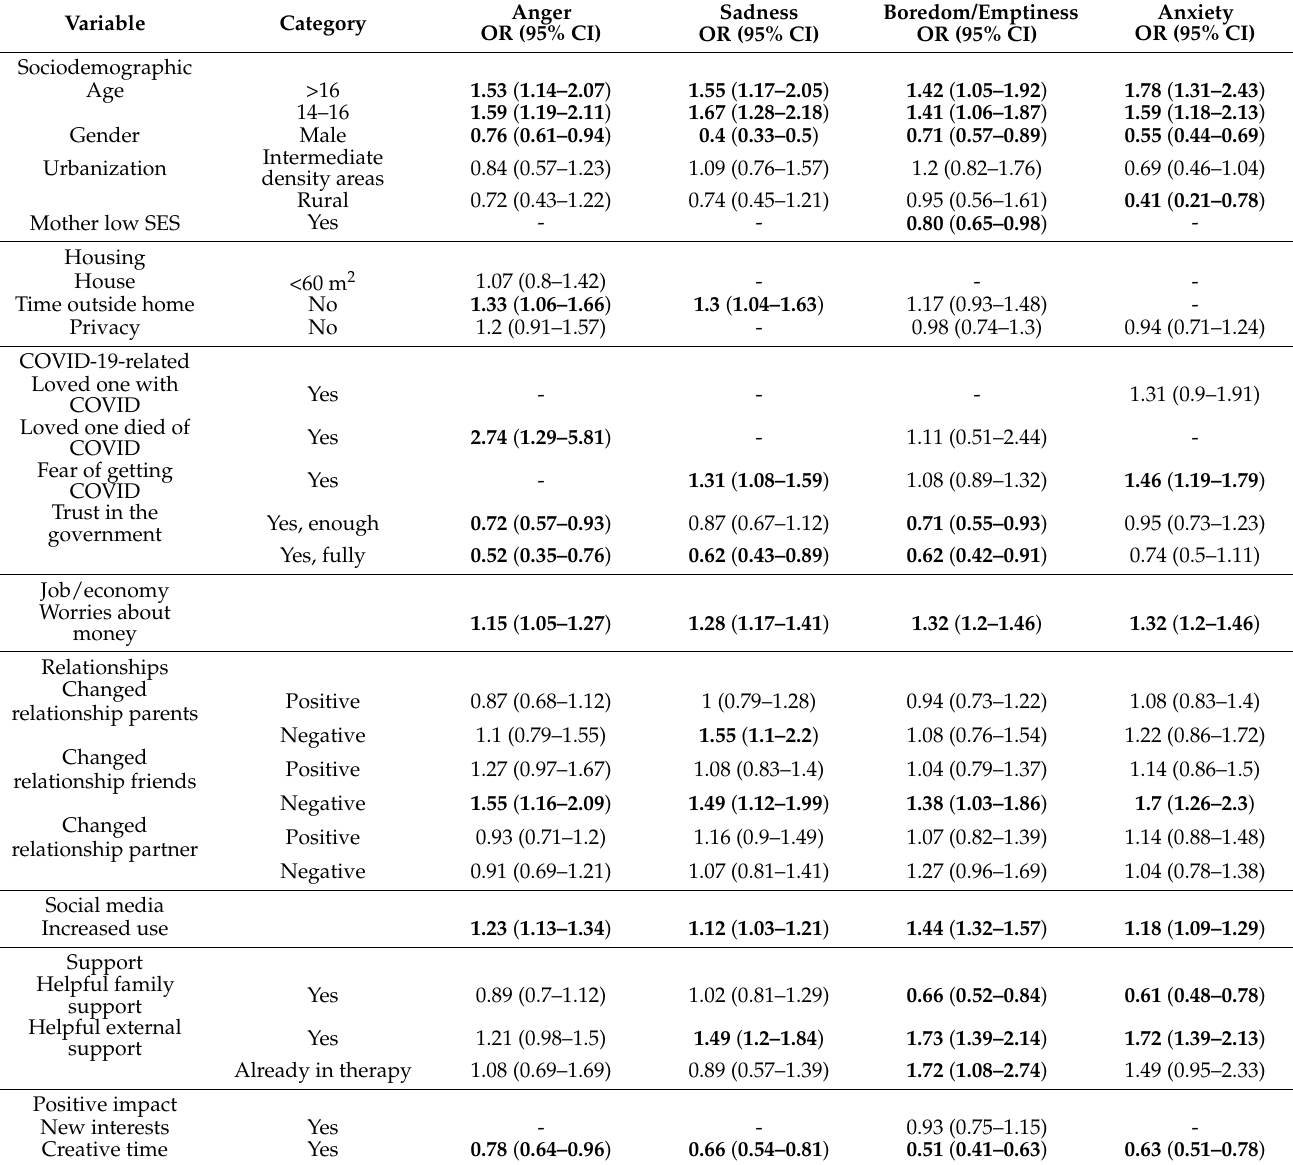
Table 3. Multivariable Analysis. Logistic regression models estimating the independent association between all the variables in column 1 (associated at p < 0.05 in the univariable analyses) and the outcomes in the last four columns; all models are also adjusted for country. Statistically significant variables are in